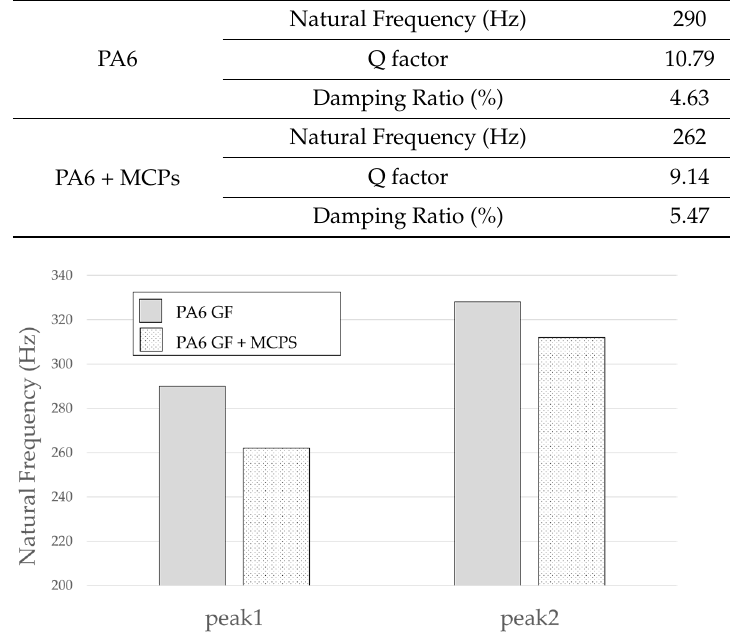
Figure 6. Effects of MCPs on Natural Frequency of plate specimen.